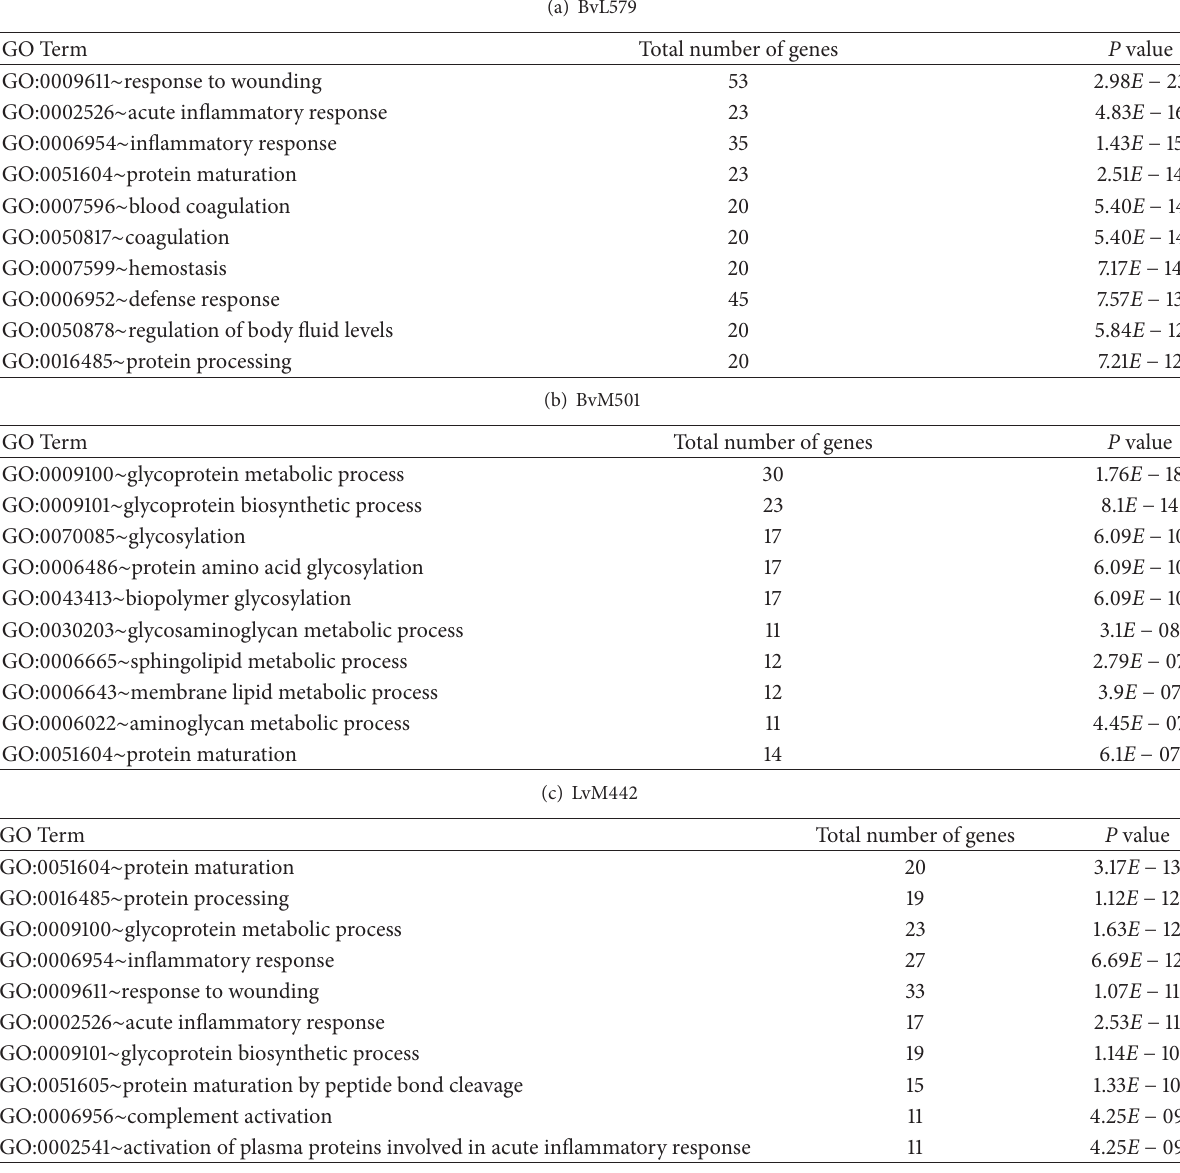
Table 2: Top 10 significantly enriched gene ontology (GO) terms detected by FAC in differentially expressed glycogenes between (a) BvL579, (b) BvM501, and (c) LvM442. Only those terms which reported a P value of ≤ 0.05 and count number ≥ 5 genes were selected for the